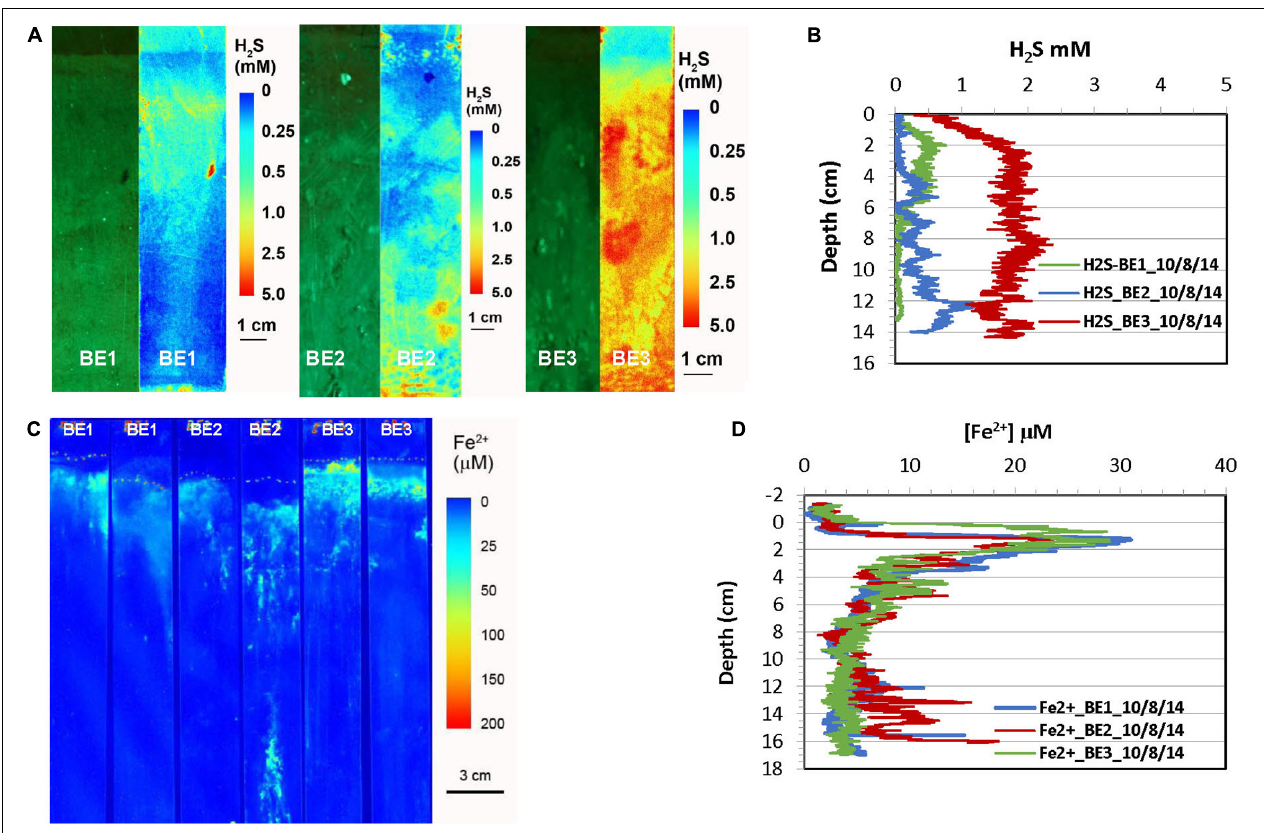
FIGURE 3 | H 2 S and dissolved Fe 2 + distribution patterns in the pore water of Big Egg (BE) marsh peats in fall 2014. (A) 2-D H 2 S distribution patterns in the sediments, which were incubated 1 day in lab before H 2 S imaging. The green panels are physical image of sediments and the color panels (pseudo color) are corresponding 2-D H 2 S distributions. (B) Vertical H 2 S profiles averaged from each 2-D H 2 S distribution in panel (A) . (C) 2-D Fe 2 + distribution patterns which were obtained by in situ deployments; dotted line marks the peat surface. (D) Vertical Fe 2 + profiles averaged from each 2-D Fe 2 + distributions in panel (C)